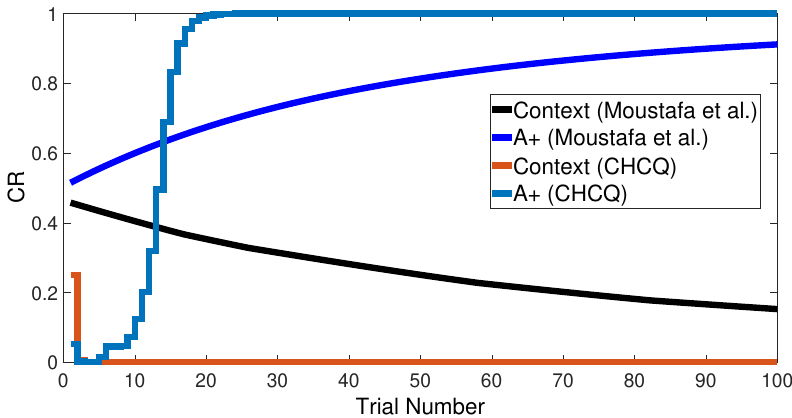
Figure 5. The cue contains context and stimulus A as <A+> task.